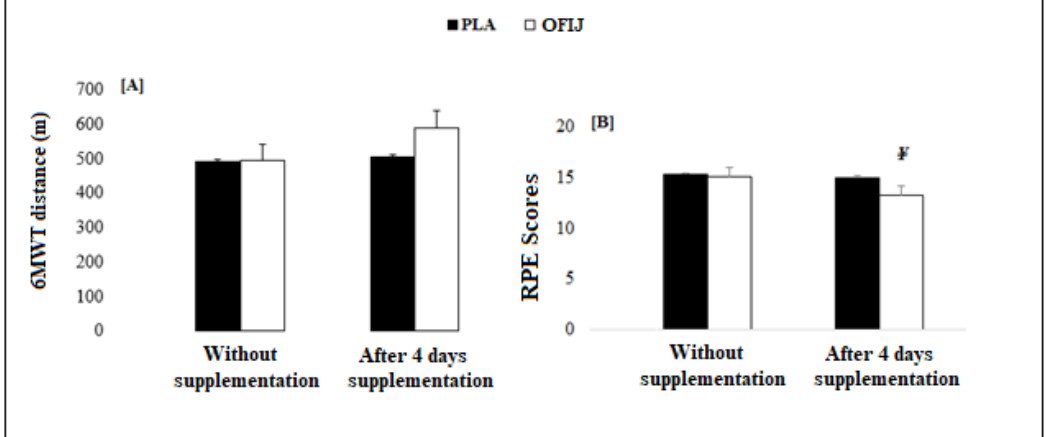
Figure 2. 6MWT [ A ] and RPE scores [ B ] (mean ± SD) without and with supplementation of PLA and OFIJ. ¥: significant difference compared with PLA ( p < 0.05).